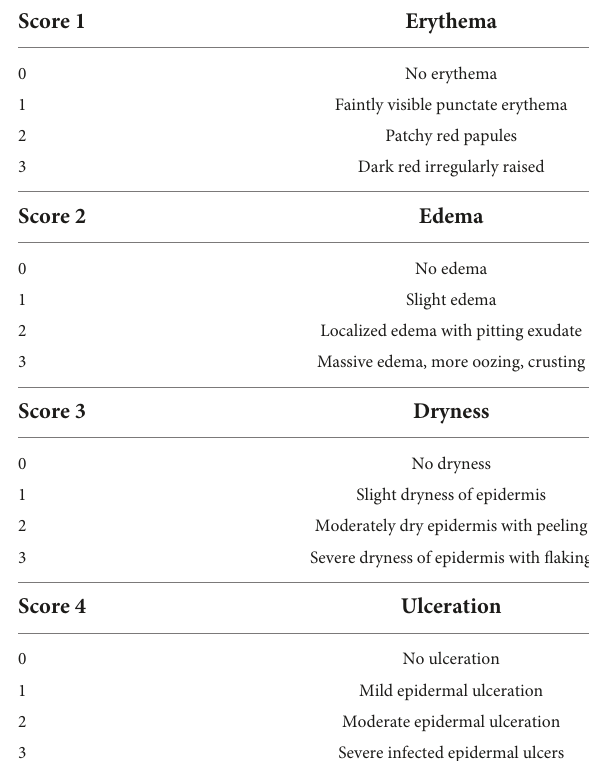
TABLE 1 AD score reference (maximum score: